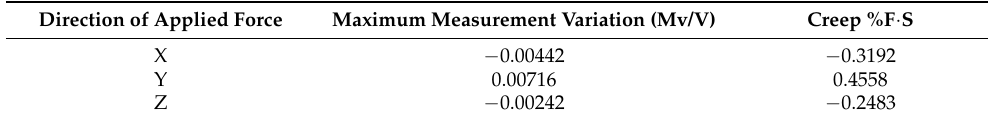
Table 2. Creep resistance of sensor 1 (see Figure